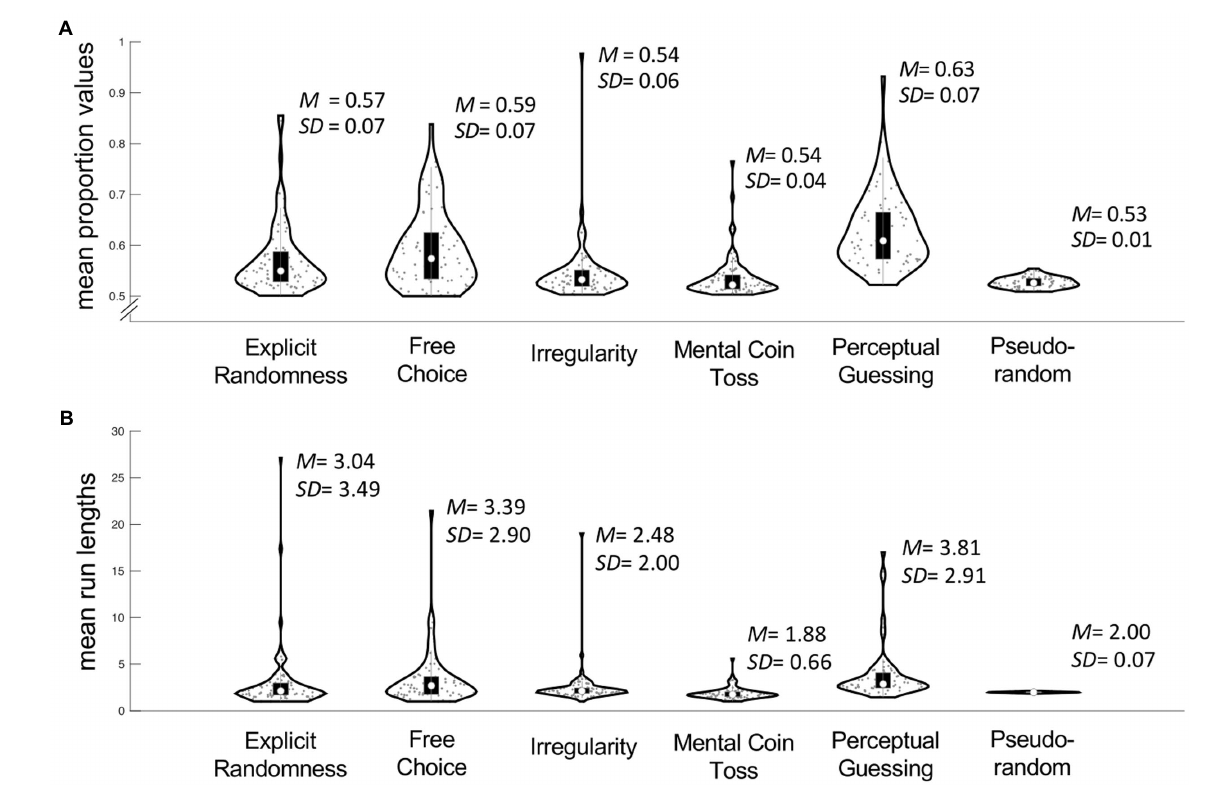
FIGURE 5 Overview of means of proportion values (A) and means of run lengths (B) averaged within subjects across five blocks and between subjects across five conditions. The outline of each violin plot shows the kernel density estimate, the black bars in the center indicate the interquartile range with the white dot representing the median.